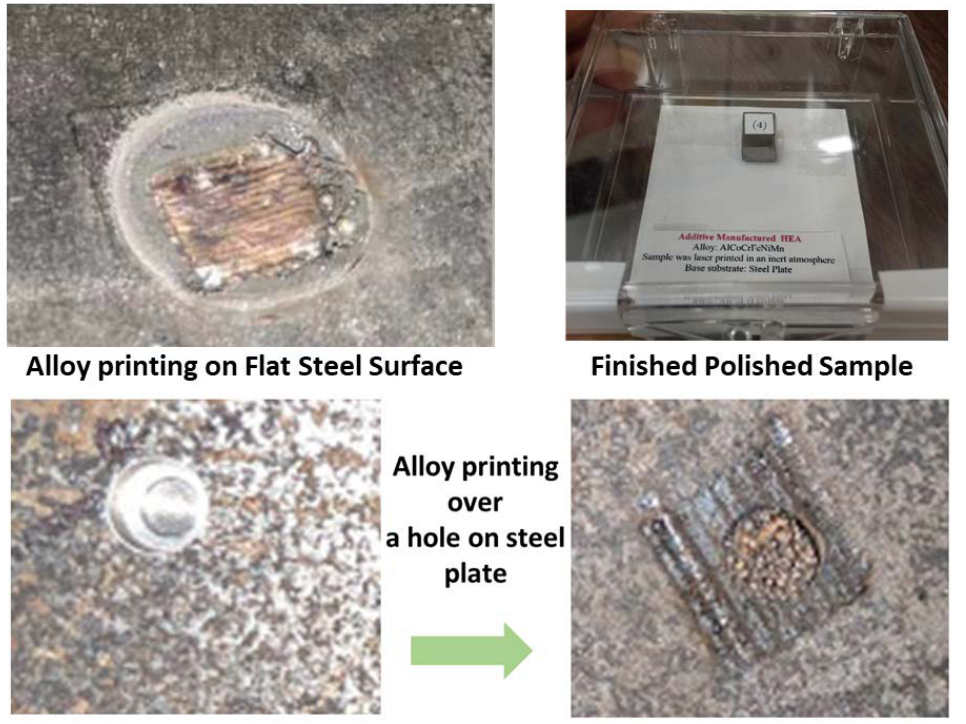
Figure A19. Alloy deposition (three layers) after optimization of various parameters.